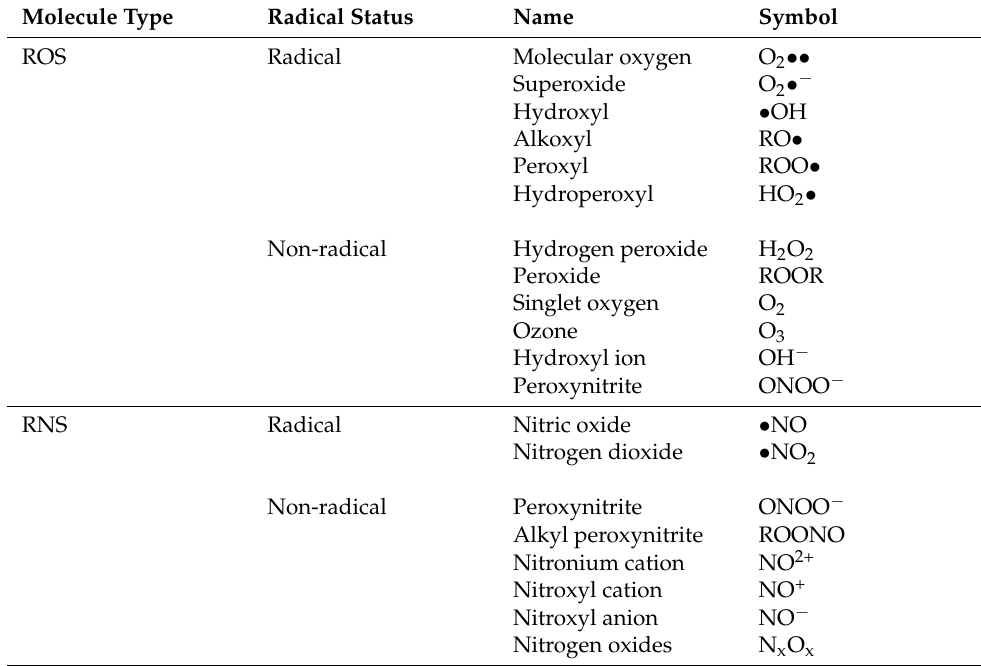
Table 1. Major Reactive Oxygen and Reactive Nitrogen